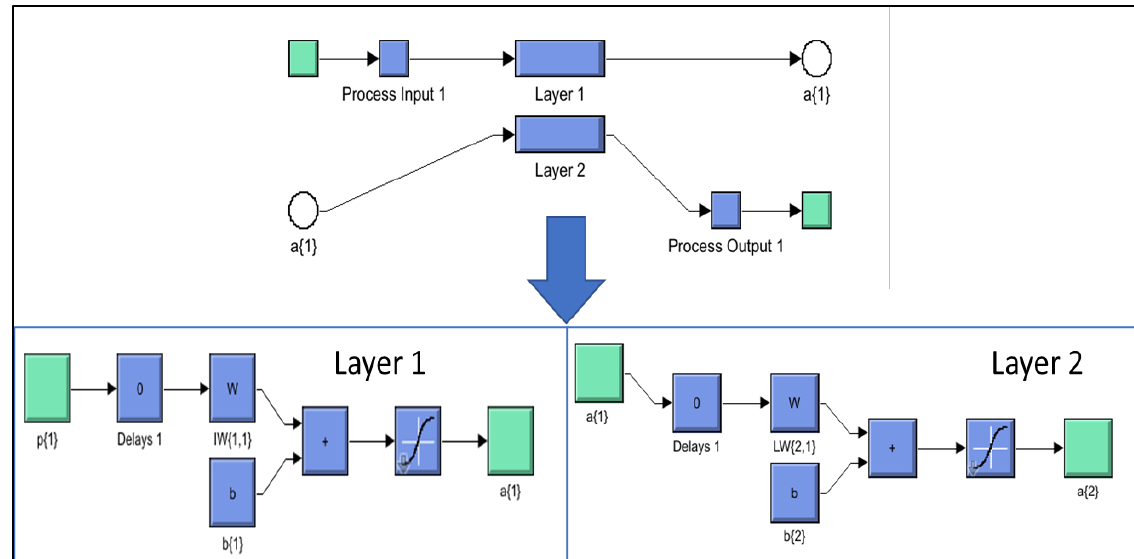
Figure 14. ANN Block and Hysteresis block in Simulink.